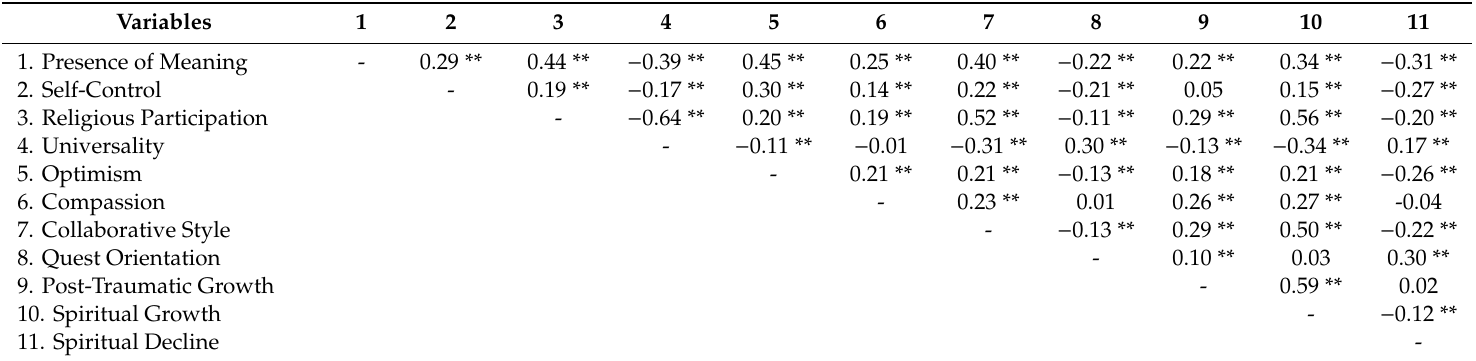
Table 2. Intercorrelations among predictor and criterions